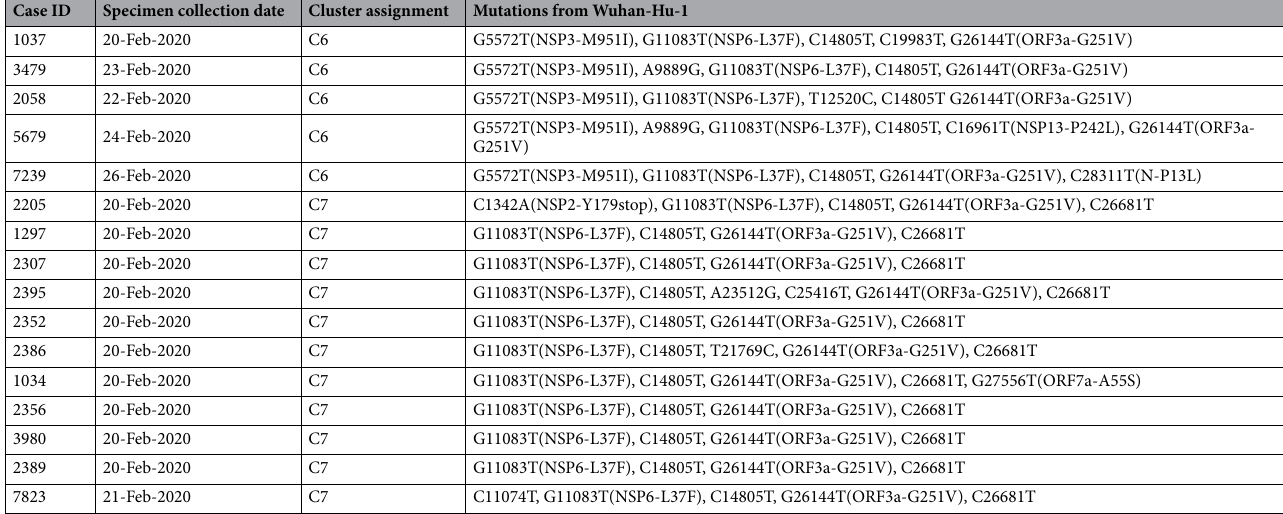
Table 2. Specimen collection date, cluster assignment and mutations from Wuhan-Hu-1 of COVID-19 cases in South Korea whose SARS-CoV-2 whole-genome sequences were reported in this study. Sequences from unmarked cases were obtained directly from patient NP/OP specimens. NA not available. *Sequence obtained via the viral cell culture method. § Sequence obtained from both patient NP/OP specimens and the viral cell culture